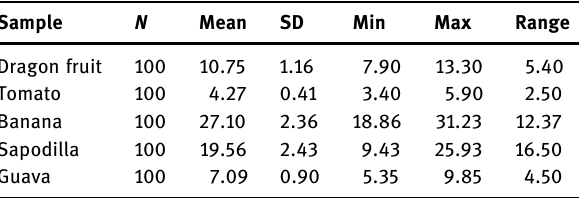
Table 1: Statistical analysis of SSC ( in °Brix ) of fruit samples Sample